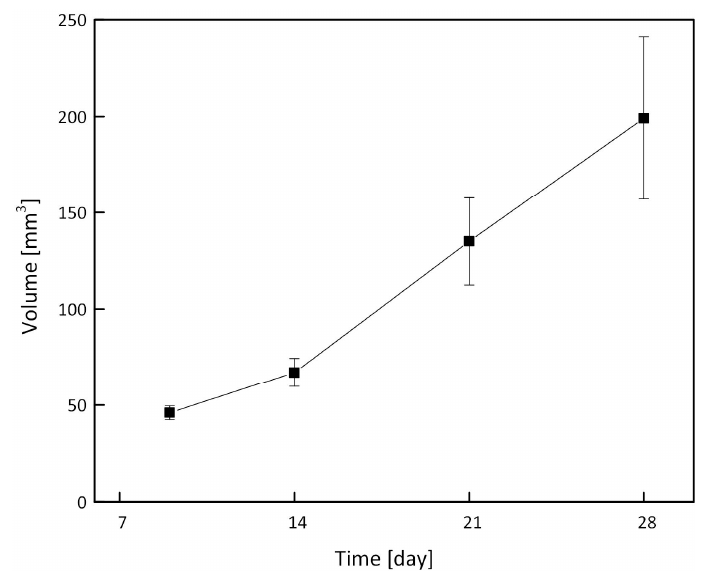
Figure 7. Tumor volume growth profile up to 28 d post tumor implantation as measured by MRI.